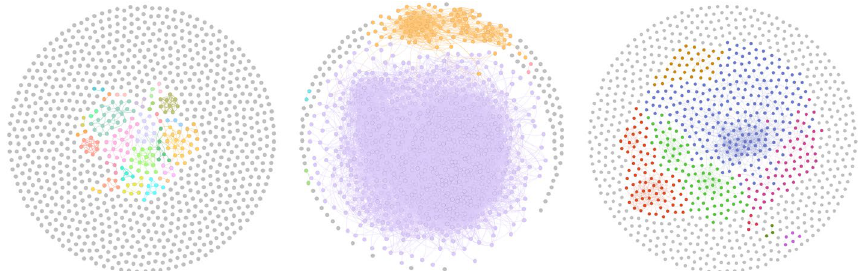
Fig. 1 Thresholding correlation networks. The researcher must solve a model selection problem when thresholding a correlation network, here exemplified by gene co-expression data from the plant Arabidopsis thaliana . As the threshold increases, more communities appear, potentially leading to overfitting (left). Including too many links (low threshold) can lead to underfitting (middle). Our module-based cross-validation method guides the researcher to the most parsimonious model